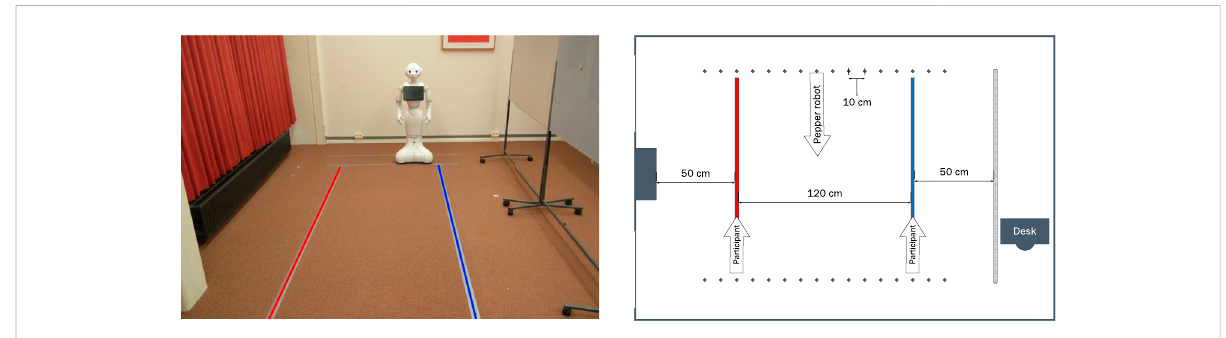
FIGURE 2 Overview of the experimental setup. In the left part of the fi gure, the experiment room, temporary walls, and the robot are shown. Participants walked on the red and blue lines. The robot had different starting positions as indicated by the dots together with a schematic overview of the dimensions in the right part of the fi gure. Reproduced from Figure 1 in Neggers et al.